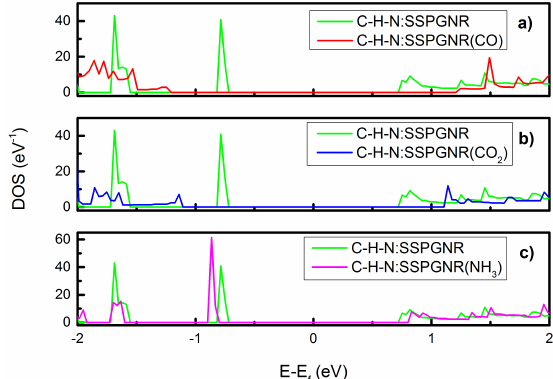
Figure 3: Density of states of systems: a) C-H-N:SSPGNR(CO) and C-H-N:SSPGNR; b) C- H-N:SSPGNR(CO 2 ) and C-H-N:SSPGNR; c) C-H- N:SSPGNR(NH 3 ) and